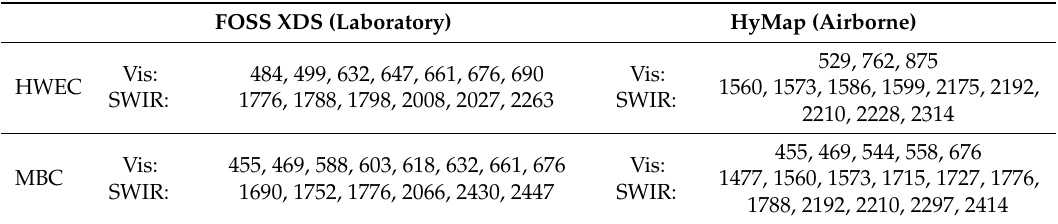
Table 5. Wavelengths with high RI values (RI > 0.02) identified on FOSS XDS and HyMap data for HWEC and MBC (Vis: 400–700 nm, NIR: >700–1300 nm, SWIR: >1300–2500 nm; central wavelengths (rounded to the nearest nm value) of the respective HyMap bands are given). FOSS XDS (Laboratory) HyMap